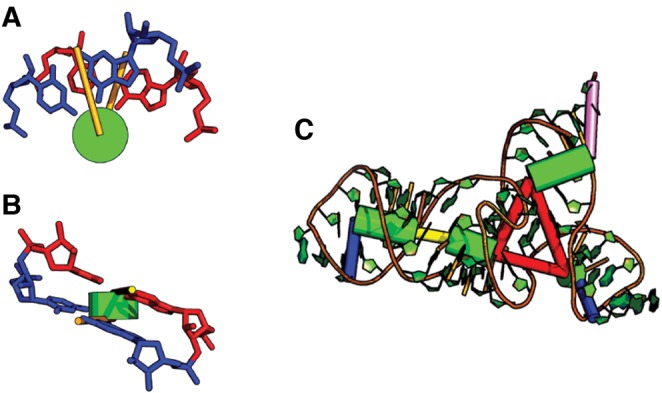
An illustration of the helix model for the 53 nucleotide SMK box (SAM-III) Riboswitch RNA structure (C, PDB: 3e5c). The helices are shown as green cylinders, interior loops as thinner yellow cylinders, multiloops as collections of red cylinders, hairpin loops as thin blue cylinders, and the 3′ unpaired region is shown in magenta. A 5′ unpaired region is missing from this structure since the first nucleotide is already paired. We denote the twist parameters as orange lines protruding from the axis of a helix as viewed along (A) and perpendicular (B) to the axis of a helix. Each one is perpendicular to the cylinder axis and points in the direction of the midpoint between the C1′ atoms of the first and last base pair in the helix. In C, twist vectors are interpolated for the base pairs in the middle of the stem with values stored only for the vectors at the end of each stem.